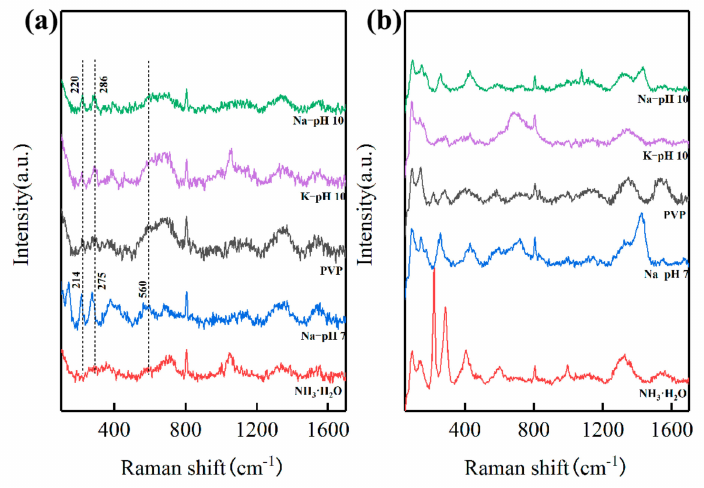
Figure 5. Raman spectra of the precursors before ( a ) and after ( b ) calcination at 800 ◦ C,